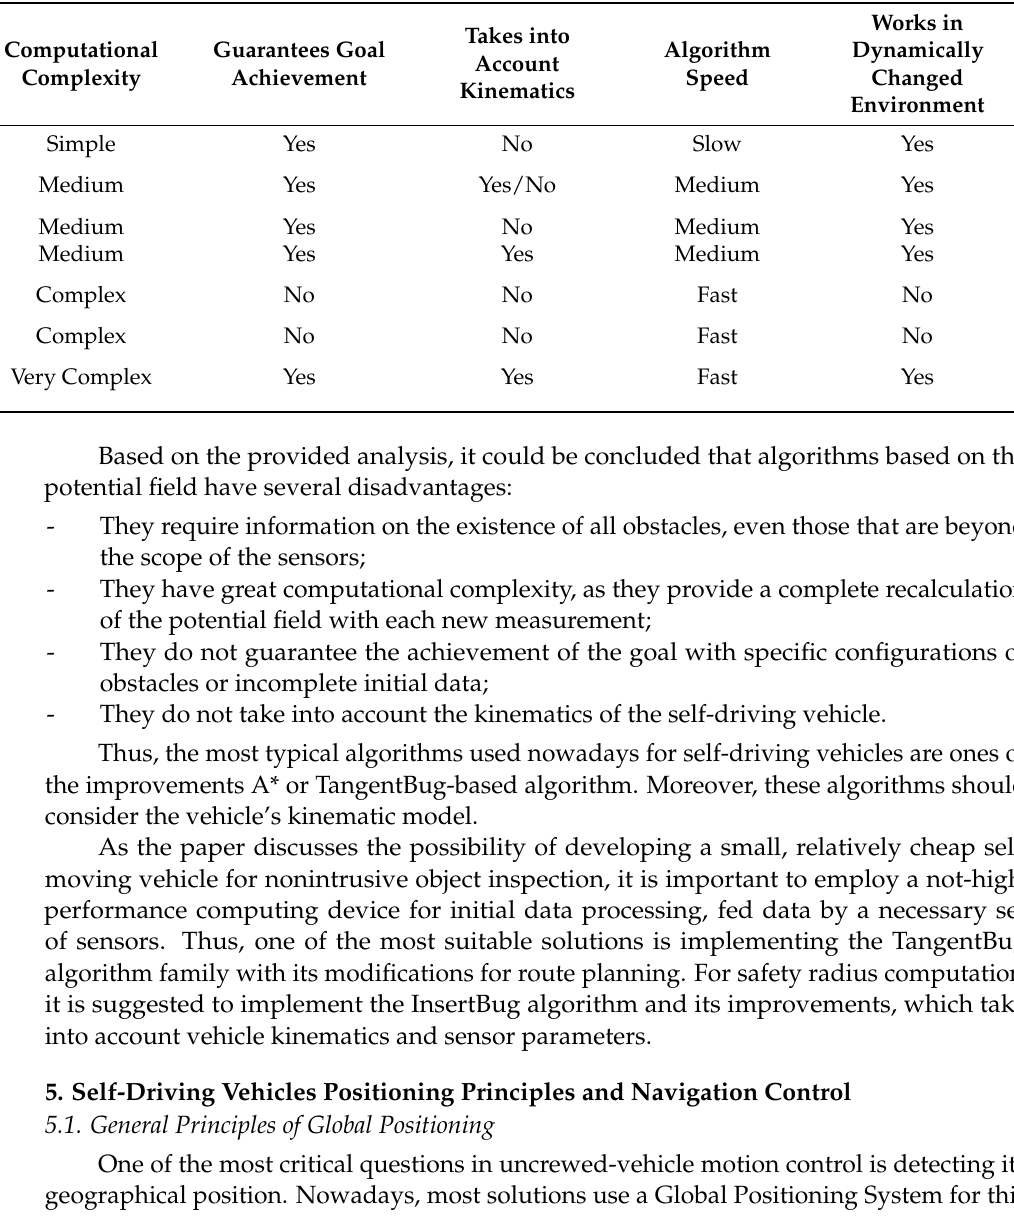
Table 2. Comparison of route-planning